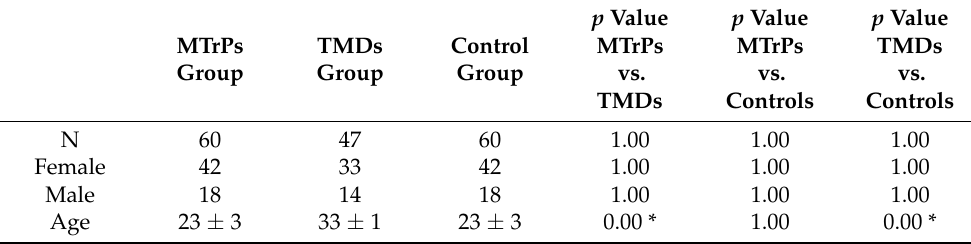
Table 1. General characteristics of